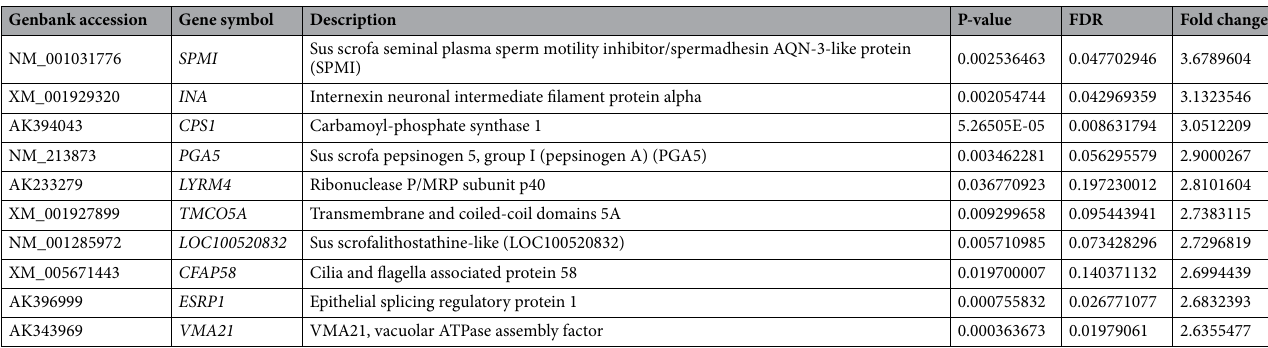
Table 2. The top ten differential genes with down-regulation.